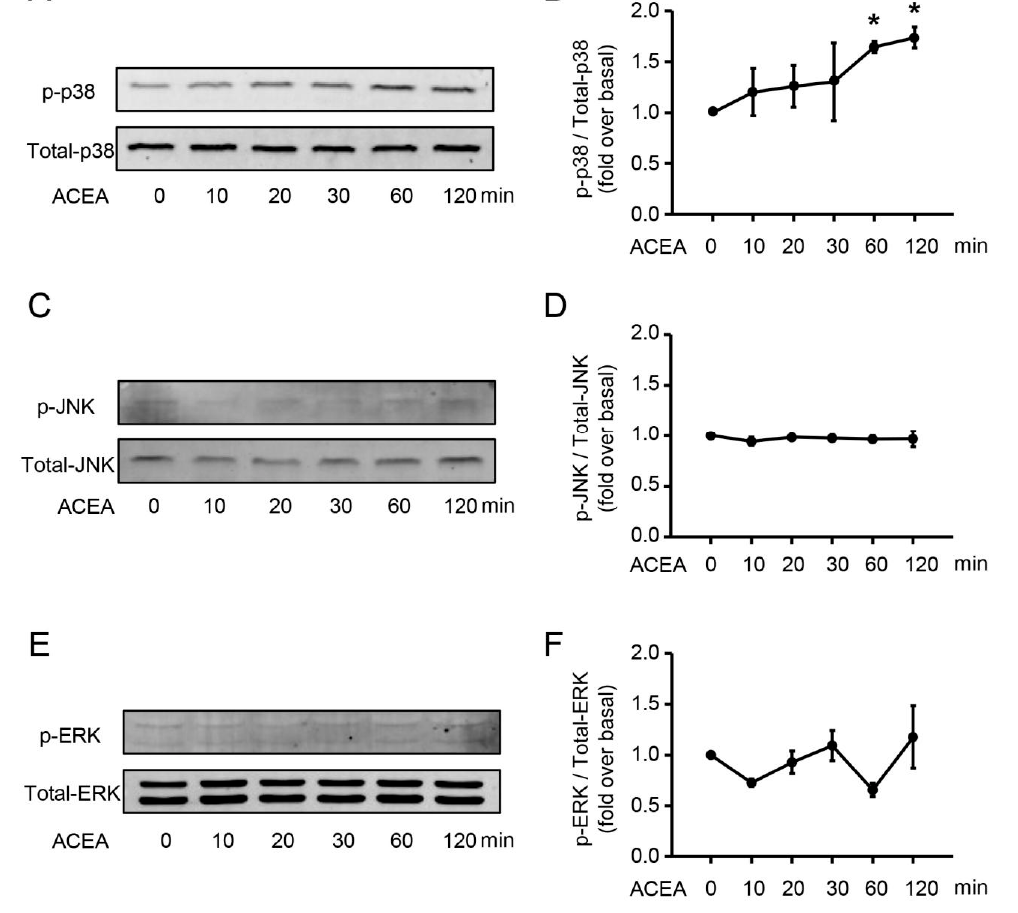
Figure 9. ACEA increases the protein level of phosphor-p38 in neutrophils. ( A , B ) Phosphor-p38 and total p38 expression after ACEA treatment was measured by Western blot. ( C , D ) Phosphor-JNK and total JNK expression. ( E , F ) Phosphor-ERK and total ERK expression.Data are presented as the mean ± SEM. N = 3 per group. * P < 0.05 vs. control.